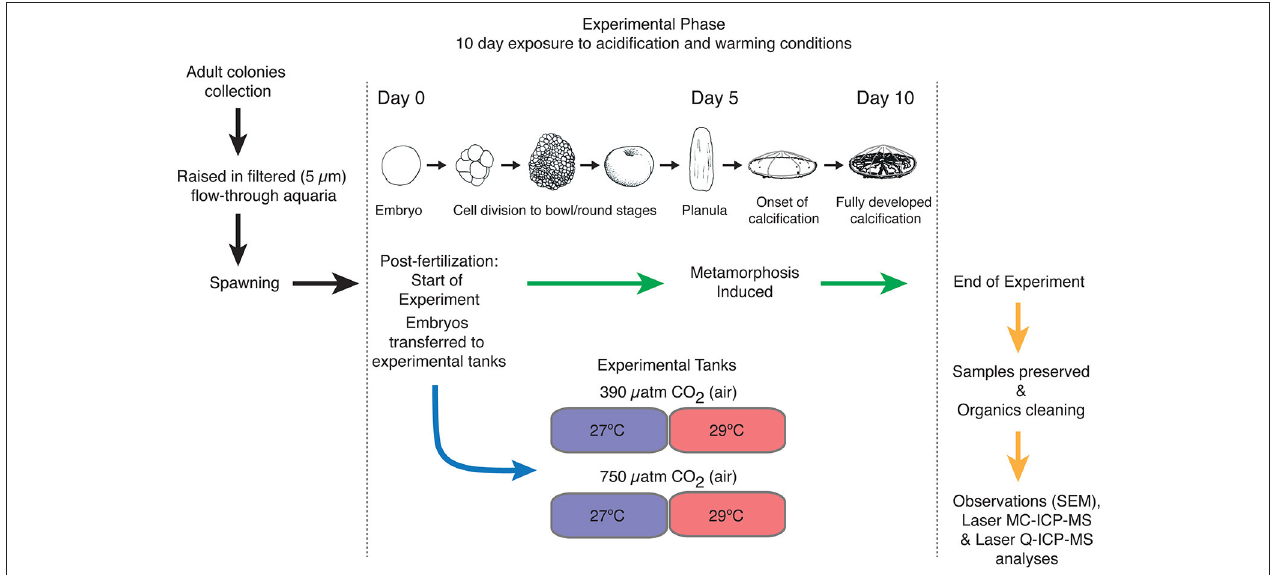
FIGURE 1 | Schematic representation of the experimental design. Adult coral colonies were collected and placed in filtered seawater (5 µ m) followed by spawning and fertilization. The embryos (Day 0) were immediately transferred to seawater that had been equilibrated with air containing 390 µ atm and 750 µ atm pCO 2 , reflecting the control and acidification condition under medium CO 2 scenario for the twenty-first century ( Field et al., 2014). Under each pCO 2 condition, two seawater temperatures were made: 27 ◦ C and 29 ◦ C. Metamorphosis of the Acropora millepora was induced (Day 5) after fertilization by the introduction of unglazed terracotta tiles conditioned with crustose coralline algae under ambient seawater conditions. At the end of the experiment after exposure (Day 10), the primary A. millepora polyps were collected and air-dried for preservation. Larval developmental stage sketches modified from Moya et al.